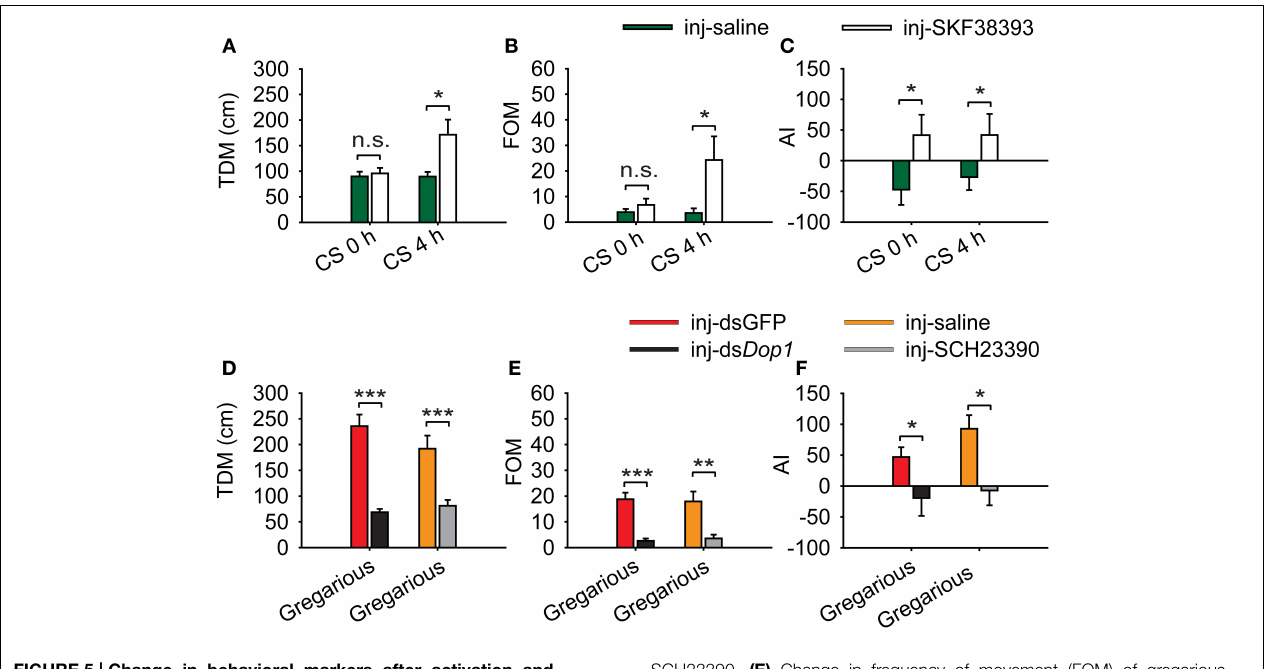
SCH23390. (E) Change in frequency of movement (FOM) of gregarious locusts after RNAi knockdown of Dop1 and injection of SCH23390. (F) Change in attraction index (AI) of gregarious locusts after RNAi knockdown of Dop1 and injection of SCH23390. Comparisons of specific behavior markers between controls and the treatments were analyzed by Student’s t -test (A,B,D,E) and Mann–Whitney U- test (C,F) . * P < 0 . 05 ; ** P < 0 . 01 ; *** P < 0 . 001 ; n.s., not significant. Abbreviations: CS, crowding of solitary locusts.